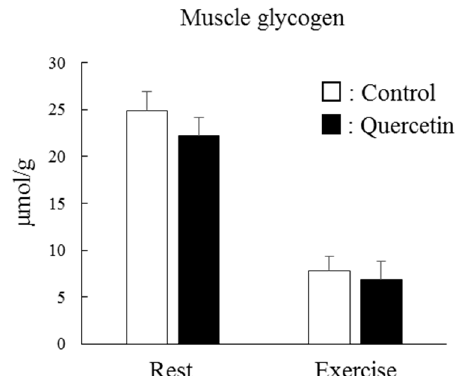
Figure 7. Effects of 7-day quercetin treatment on exercise-induced glycogen metabolism. Rats were assigned to either a control or quercetin groups and were maintained under ad libitum feeding for 7 days. After that, rats underwent swimming exercise for 1 hour. Immediately after exercise, epitrochlearis muscles were dissected out as samples. Values are means ± SE ( n = 6–7).